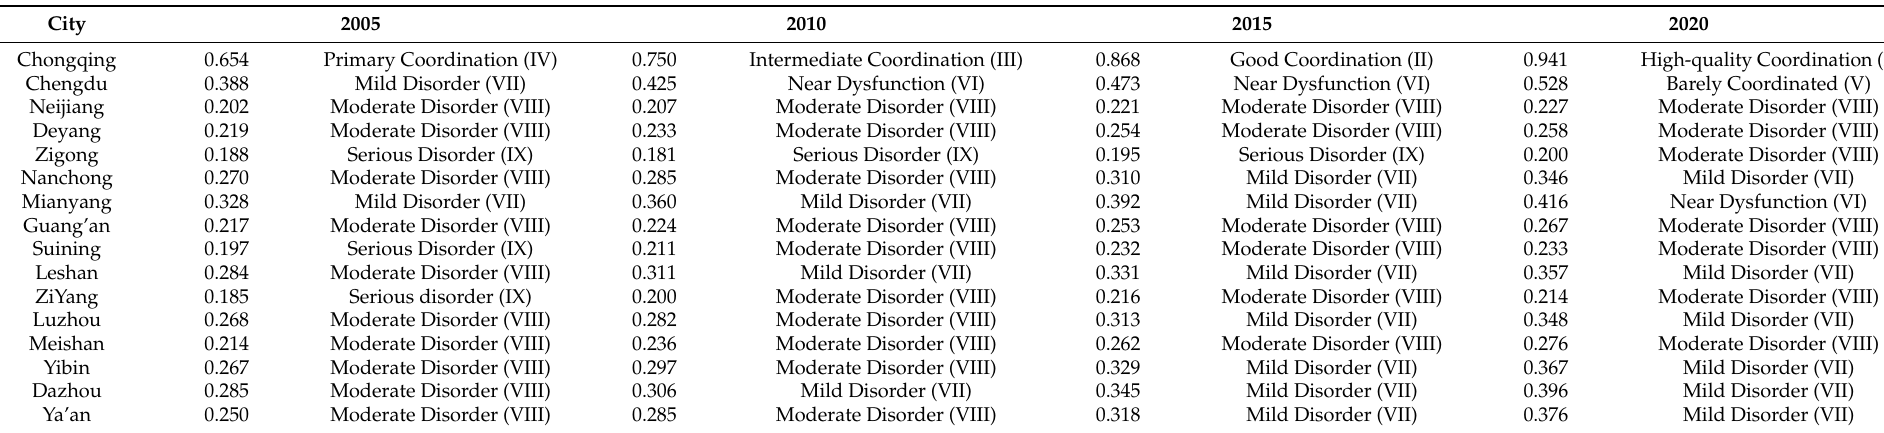
Table 9. Levels of coupling between economic–social development and ecological service system in CCCG,